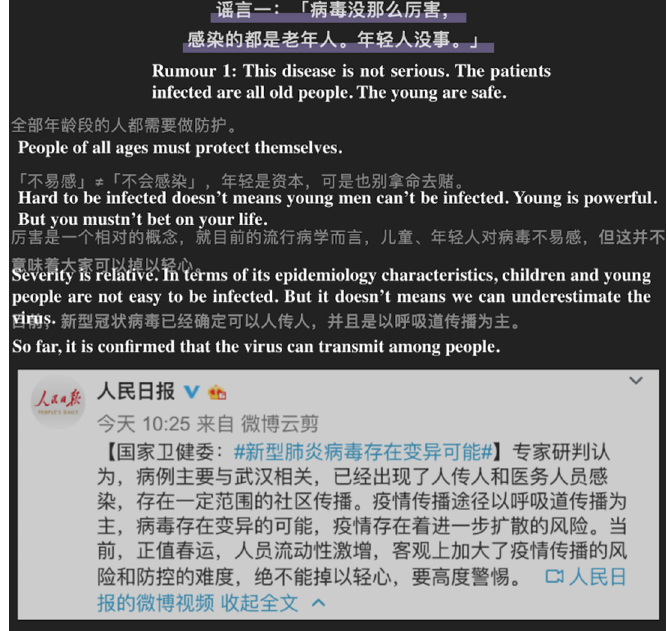
Figure 4. Screenshot of a counter-rumor article. From: DingXiangYiSheng. Novel coronavirus fears alcohol and high temperature, but vinegar, saline, and smoke are useless: 11 rumors you need to know.